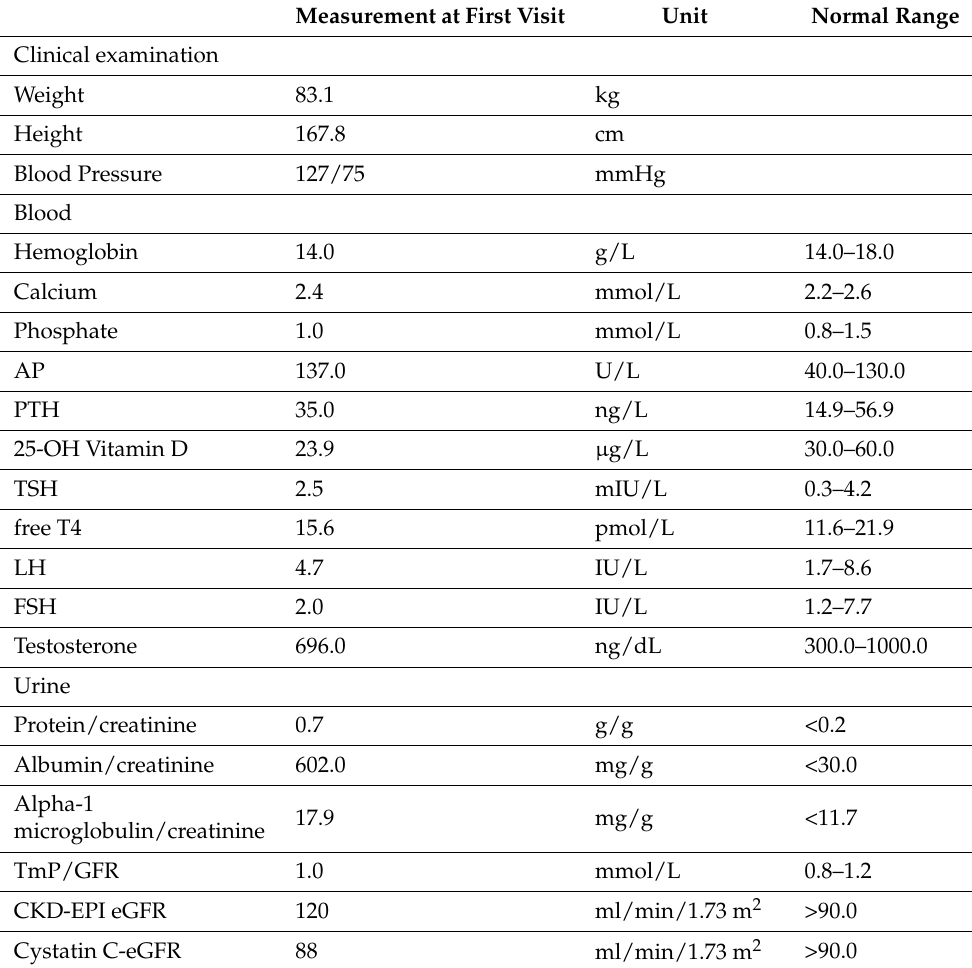
Table 1. Clinical and technical examination of the patient at the last follow-up: blood and urine laboratory values shows pronounced proteinuria without renal Fanconi